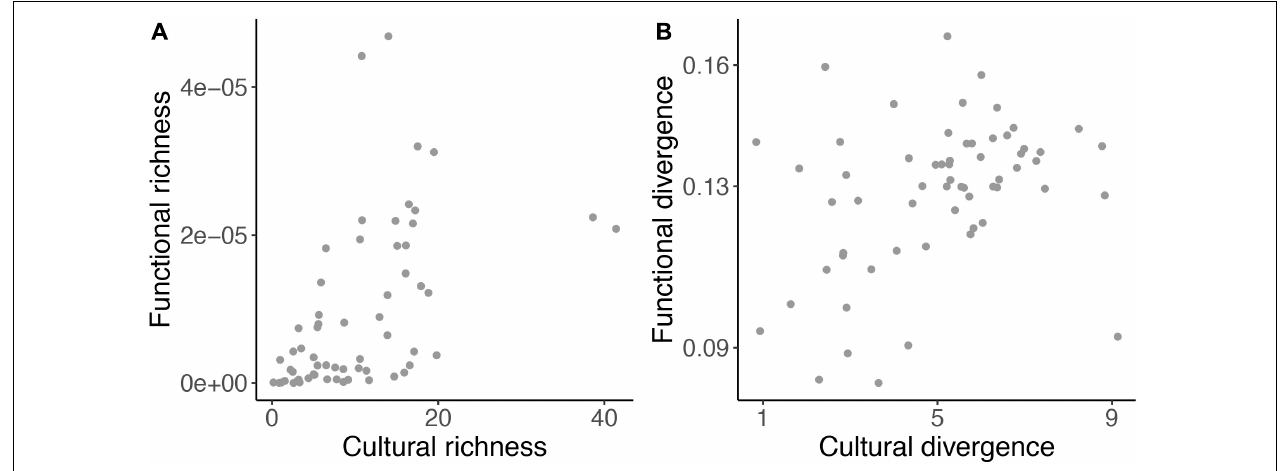
FIGURE 3 | Relationships between cultural and functional richness (A) , and cultural and functional divergence (B) for bird sampled in 61 hexagons in Campo Grande, central Brazil.